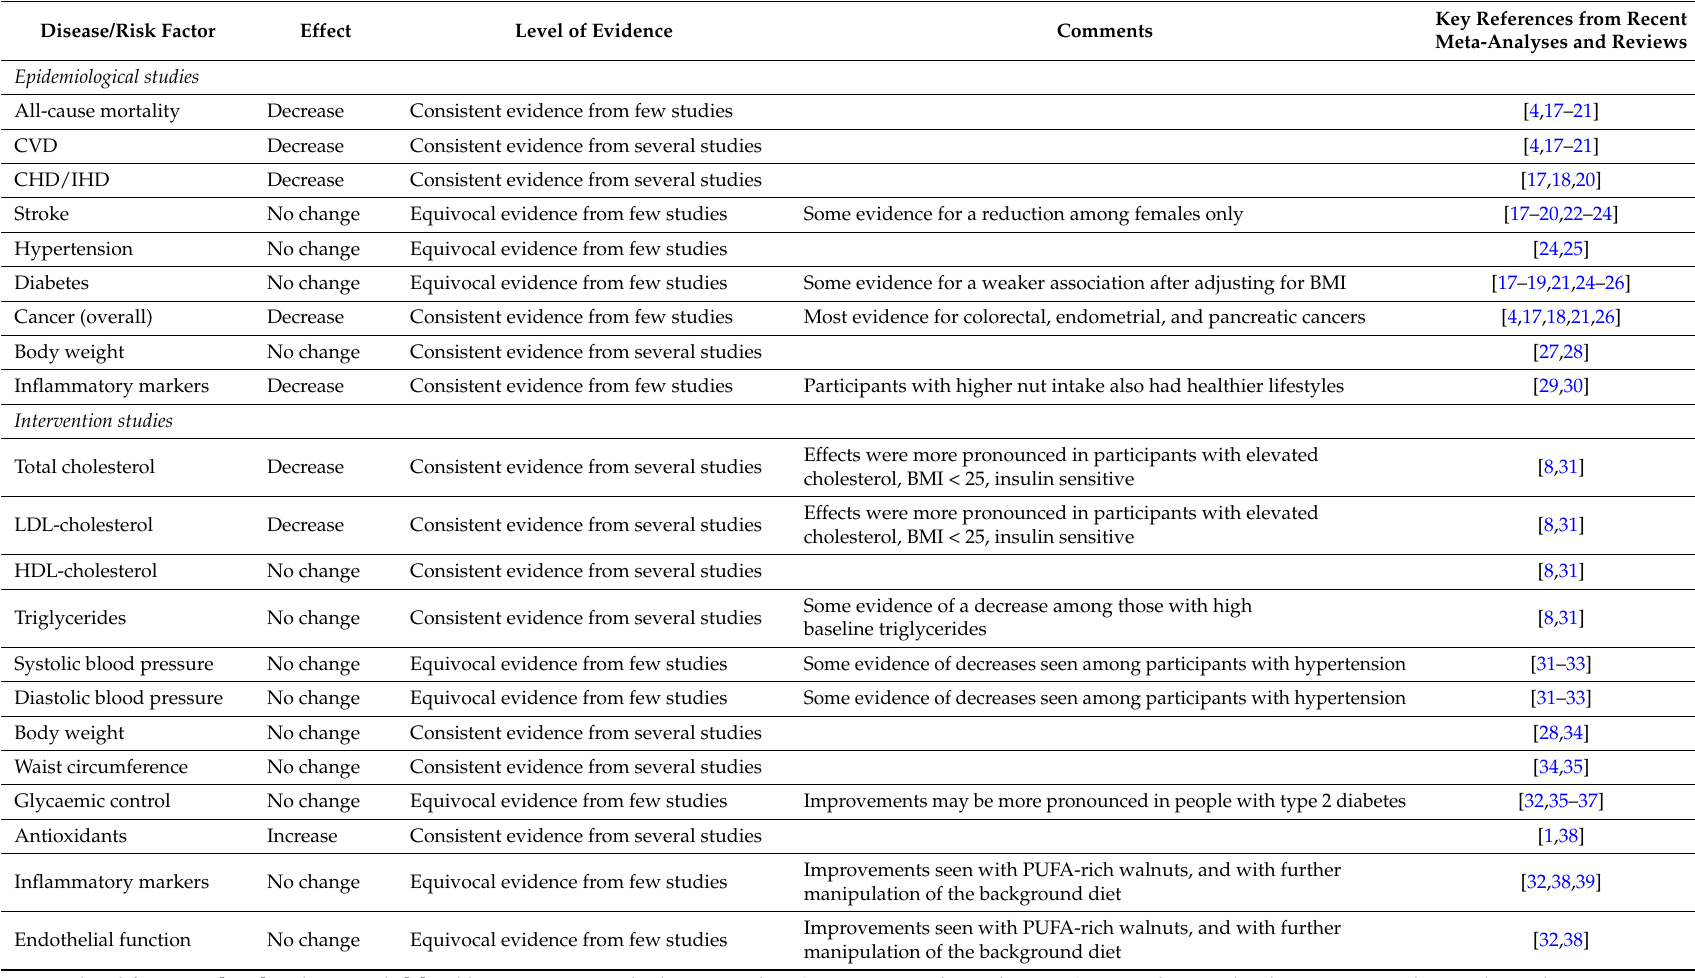
Table 1. Summary of the evidence for the health effects of nut